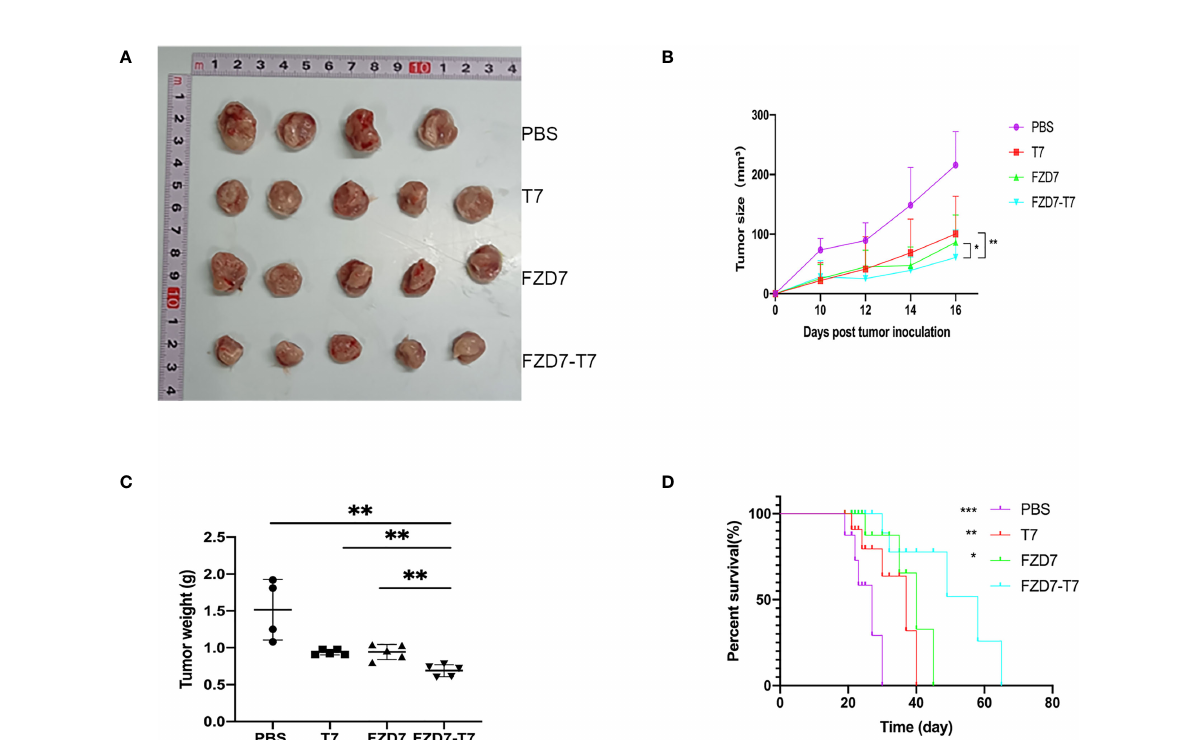
FIGURE 5 Anti-tumor effects of the FZD7 vaccine. (A) Image of tumor size. (B) Tumor volume (mm3) was assessed every two days. (C) tumor weight. (D) Survival curve of mice after tumor growth. * P < 0.05, ** P < 0.01, *** P <